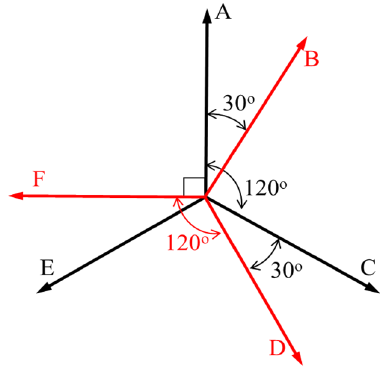
Figure 4. Voltage and current waveforms of rotor Type − I.